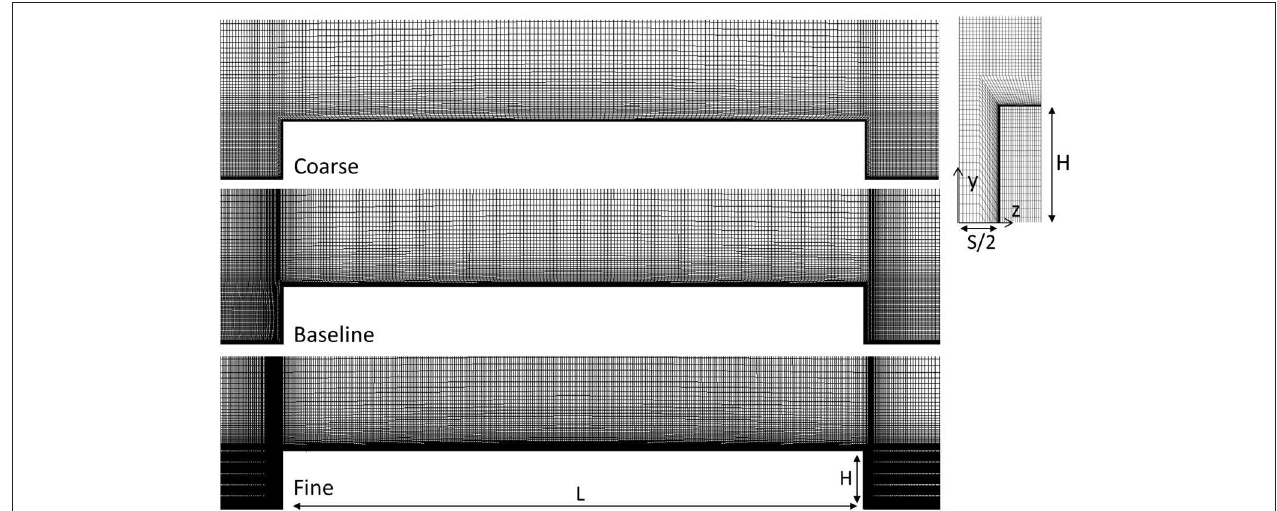
FIGURE 3 | Grids used in grid-sensitivity study.